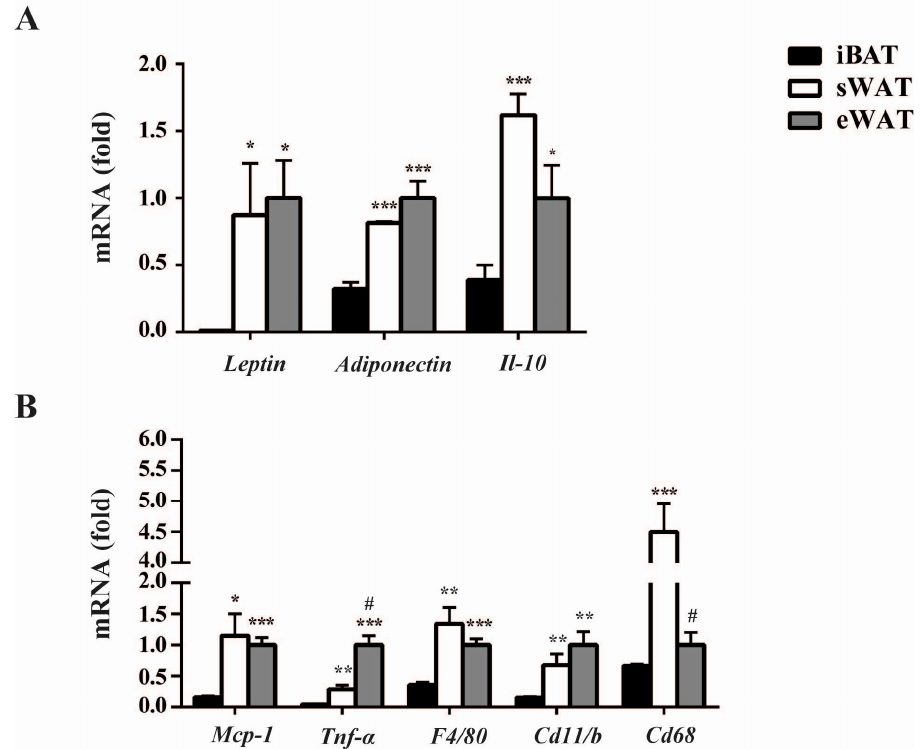
Figure 1. Inflammatory adipokines expression levels exhibit depot-specificity in mice adipose tissues at baseline (in room temperature without any treatment). Quantitative PCR analysis of anti-inflammatory ( A ) and pro-inflammatory ( B ) adipokines genes expression in iBAT, sWAT and eWAT at baseline. The data show the fold changes of the expressions for the target genes in interscapular brown adipose tissue (iBAT), inguinal subcutaneous WAT (sWAT) and epididymal WAT (eWAT) of RT (room temperature) mice ( n = 6 for each group). Values are mean ± S.E.M. and expression of genes is corrected for the housekeeping gene Cyclophilin . (* p < 0.05, ** p < 0.01, *** p < 0.001 vs. the expression level of iBAT, while # p < 0.05 vs. the expression level of sWAT.)